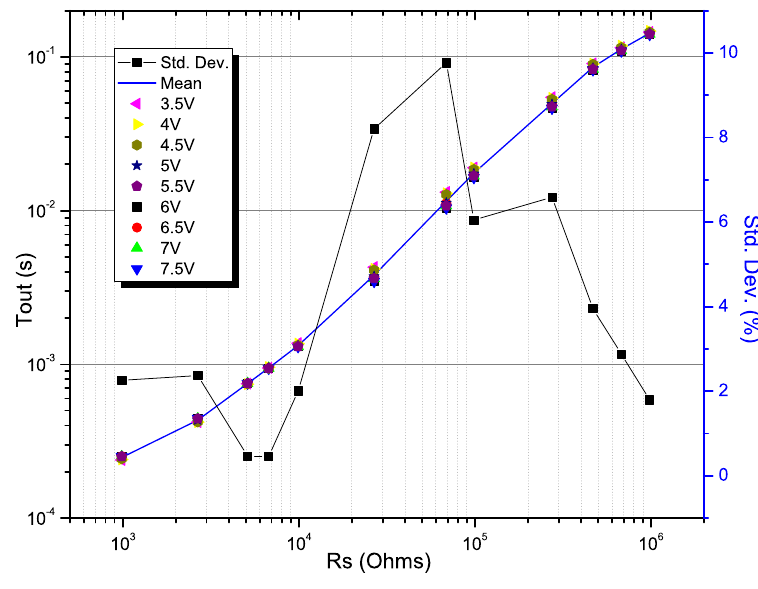
Figure 12. Period as function of the sample resistors. Experimental results with sweep from 3.5 to 7.5 V in the power